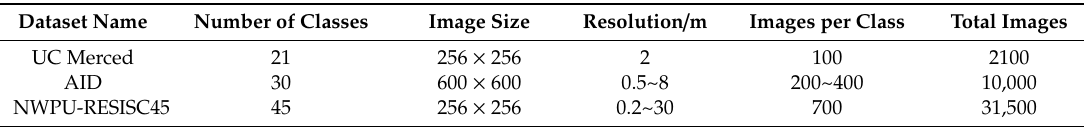
Table 1. Dataset Table 1. Dataset information.